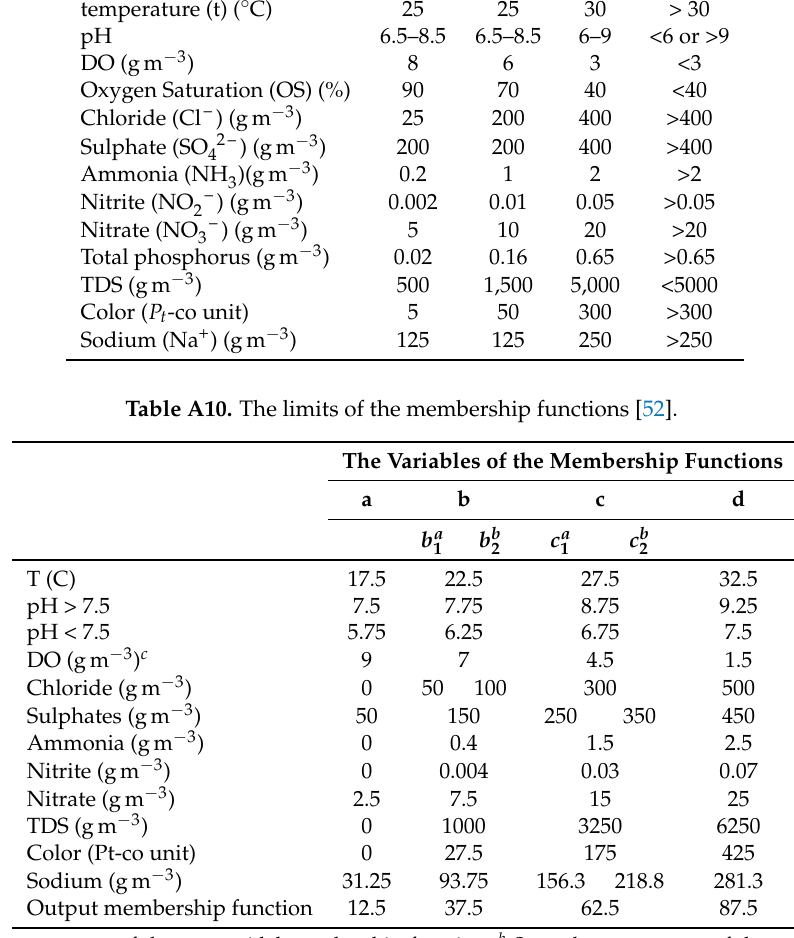
Table A9. Quality classes for physical and inorganic chemical variables of inside water resources [52]. Variable